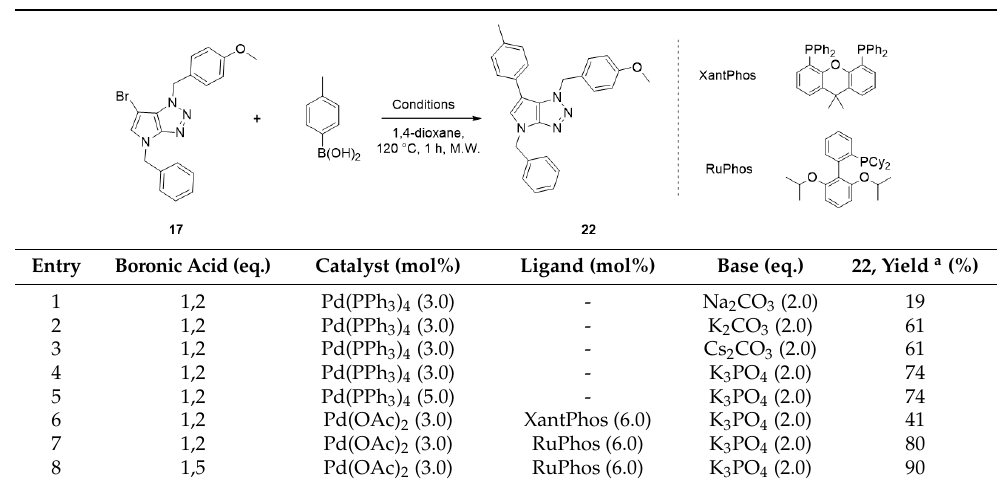
Table 4. Optimization of Suzuki–Miyaura cross-coupling.